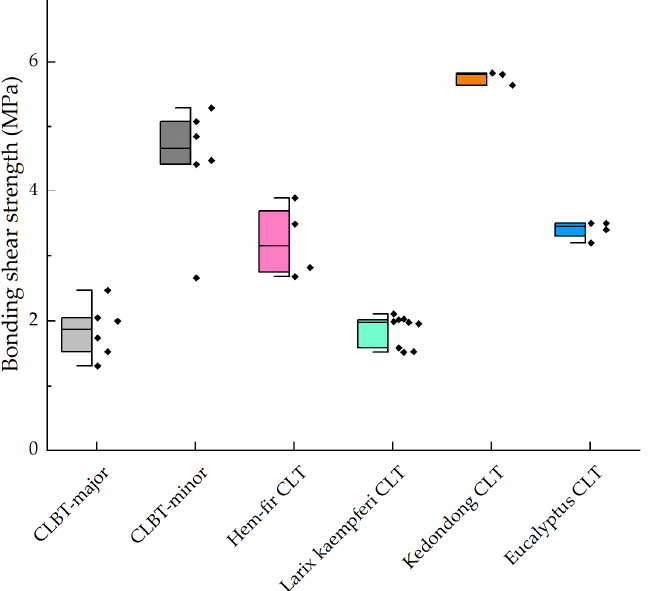
Figure 5. Comparison of bonding shear strength of CLBT and CLT; Hem-fir CLT [26], Larix kaempferi CLT [30], Kedondong CLT [33], Eucalyptus CLT [43].